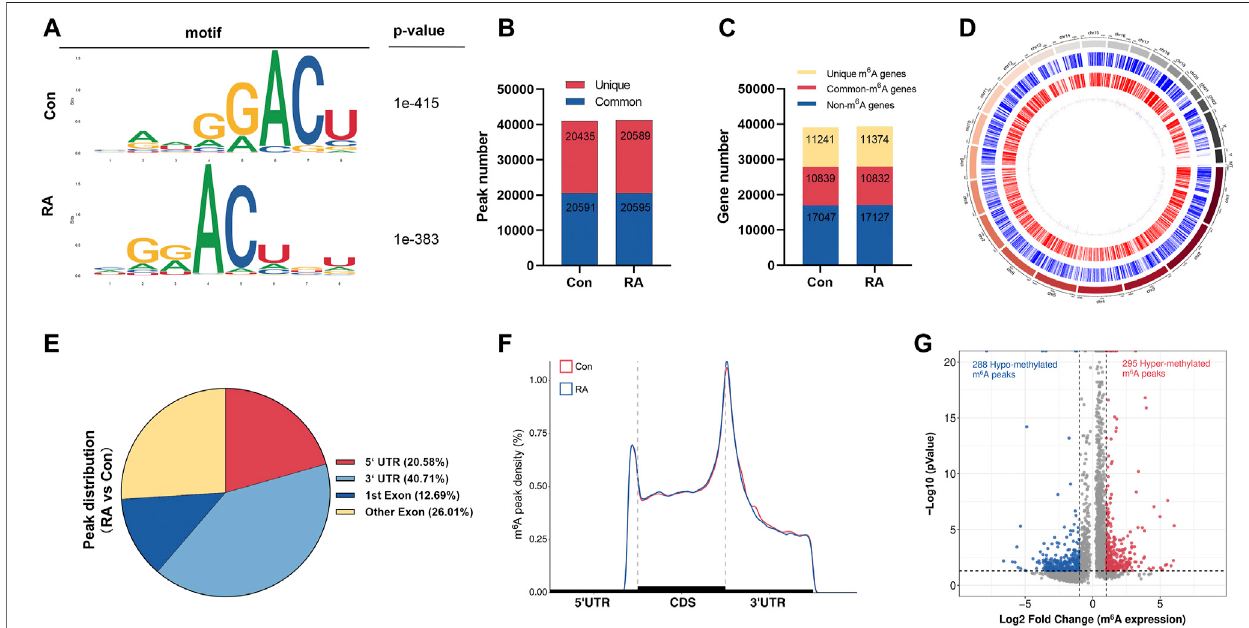
FIGURE1 | Characteristics ofm 6 Amethylation inRA PBMCs. (A) Recognition ofthe top consensus motif from m 6 Apeaks determined in PBMCs from theRA and Con groups. (B) Number of m 6 A peaks recognized by m 6 A-seq in the RA and Con groups. (C) Summary of the m 6 A-altered genes identi fi ed using m 6 A-seq. (D) Distribution patterns of m 6 A peaks in various chromosomes. (E) m 6 A modi fi cation distribution in different gene contexts. (F) Accumulation of m 6 A peaks across transcriptsfalleninto5 ′ -UTR,CDS,and3 ′ -UTR. (G) Recognitionoftheabundanceofhypermethylatedandhypomethylatedm 6 ApeaksintheRAPBMCsrelativeto that of the Con group. m 6 A, N 6 -methyladenosine; RA, rheumatoid arthritis; PBMCs, peripheral blood mononuclear cells; and Con, control